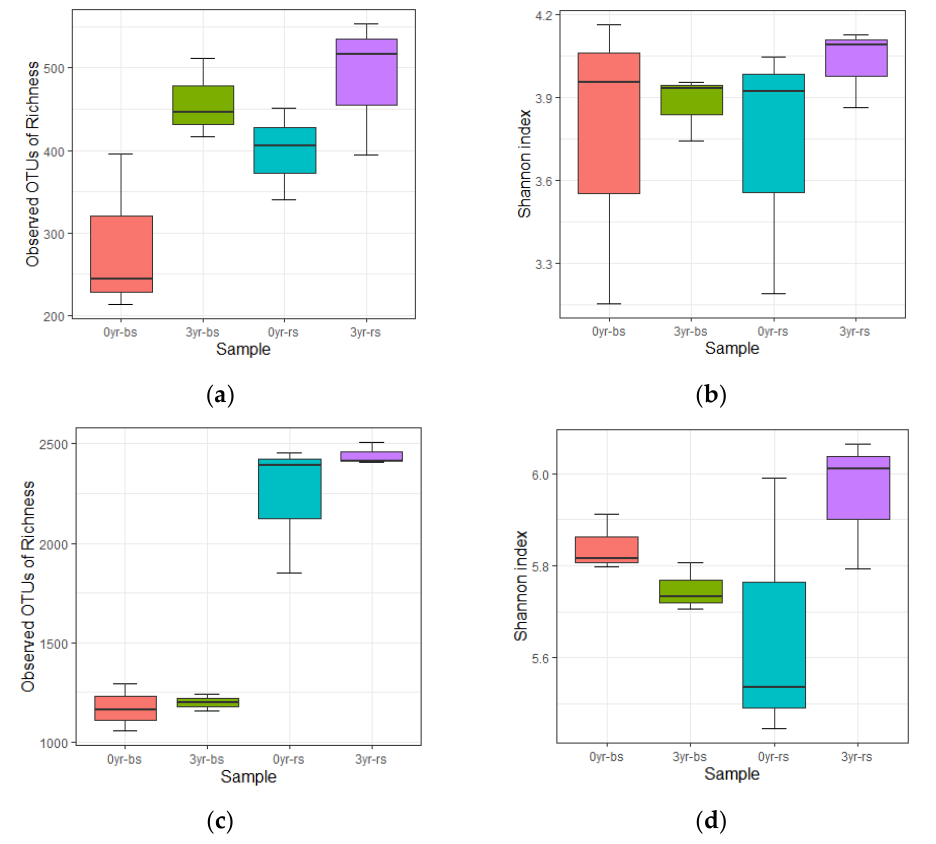
Figure 3. Fungal and bacterial OTU richness and Shannon index of American ginseng rhizosphere when grown in soils with different monoculture history: fungal OTU richness ( a ); fungal Shannon index ( b ); bacterial OTU richness ( c ); bacterial Shannon index ( d ); 0 yr-bs: bulk soil with no American ginseng growing history; 3 yr-bs: bulk soil with 3-year monoculture; 0 yr-rs: rhizosphere in the soil with no American ginseng growing history; 3 yr-rs: rhizosphere in the soil with 3-year monoculture. The detailed information of the ANOVA results are shown in Table A1.